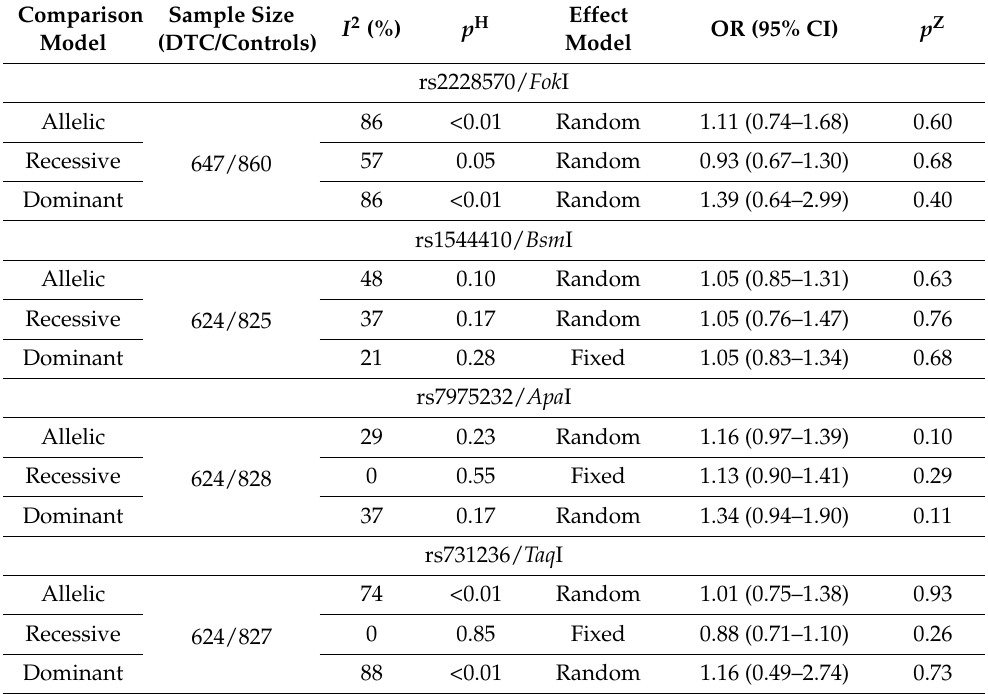
Table 3. Meta-analysis results—association between four vitamin D receptor gene